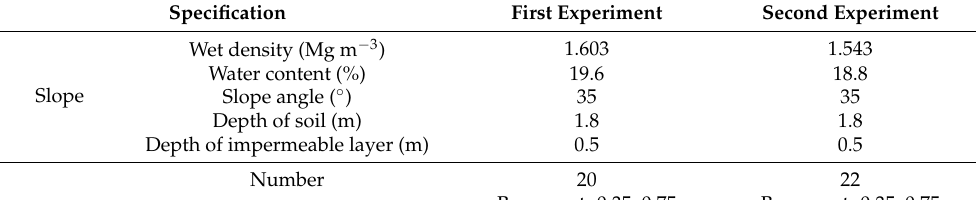
Figure 13. Full-scale flume experimental results (first experiment): ( a ) small-scale failure; ( b ) second failure (shallow failure).